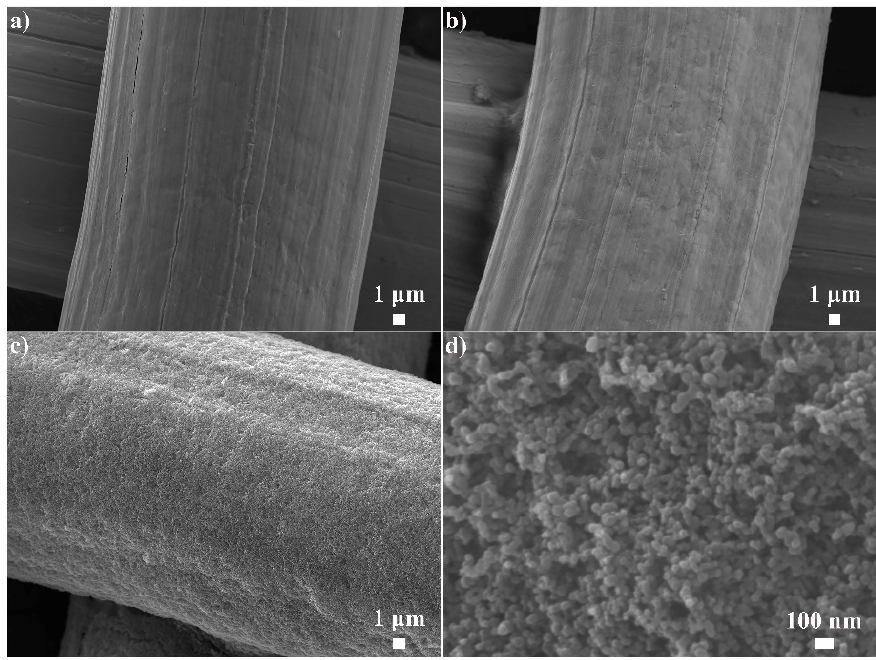
Figure 2. SEM images of ( a ) the pristine SSM, ( b ) glued SSM, and ( c , d ) CS-coated mesh with low and high magnifications.